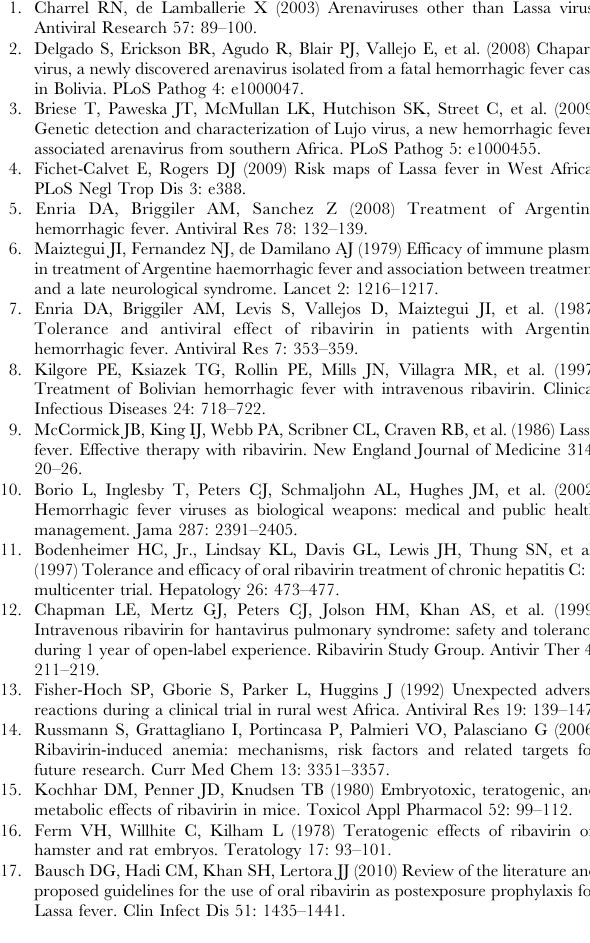
Table S3 Hematology and blood chemistry analysis of guinea pigs treated for 10 days with favipiravir a . a Guinea pigs (n= 5/group) treated orally twice daily for ten days with the indicated doses of favipiravir and sacrificed 7 days after the final dose was administered. Whole blood and sera were analyzed for hematology and blood chemistry. WBC, white blood cells;